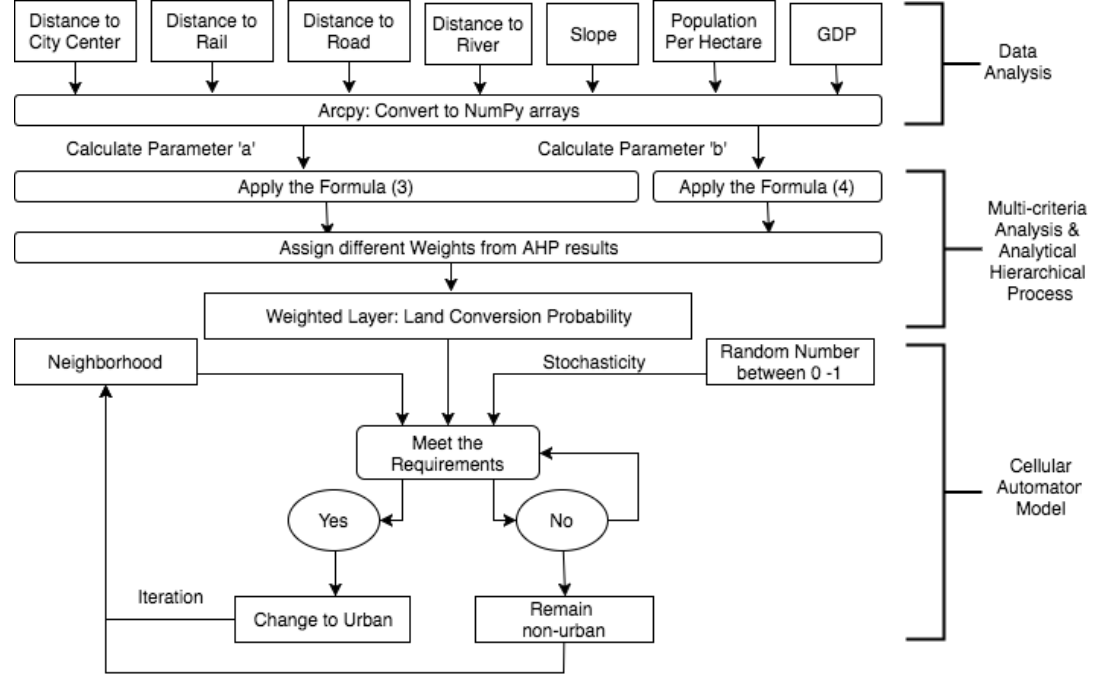
Figure 2. Methodology